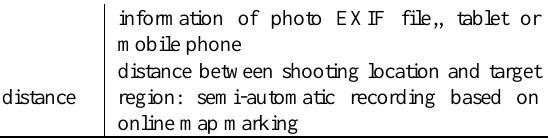
Table 1: Attributes designed for RSAIS recording